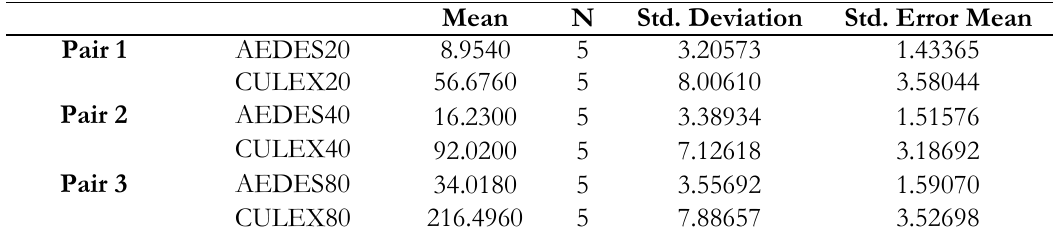
Table III : Paired t-test comparing mean duration time of reppllency effectivity citronella oil lotion at concentration of 20%, 40%, 80% between Culex sp. and Aedes sp.